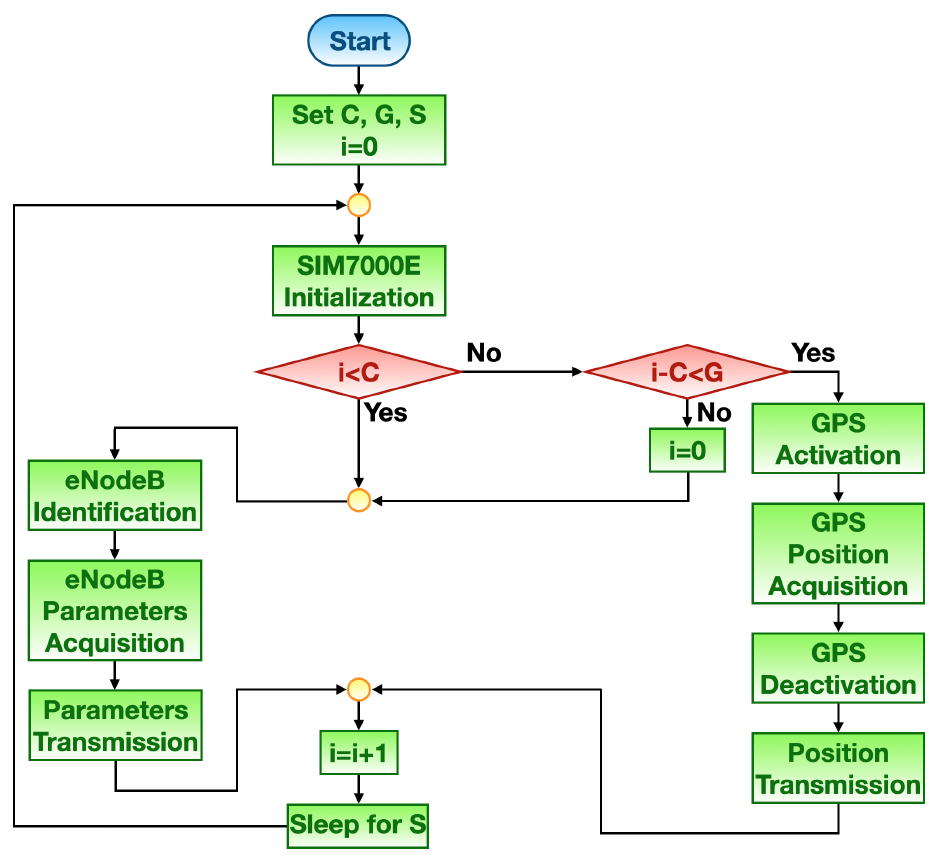
Figure 3. Mode #1 flow